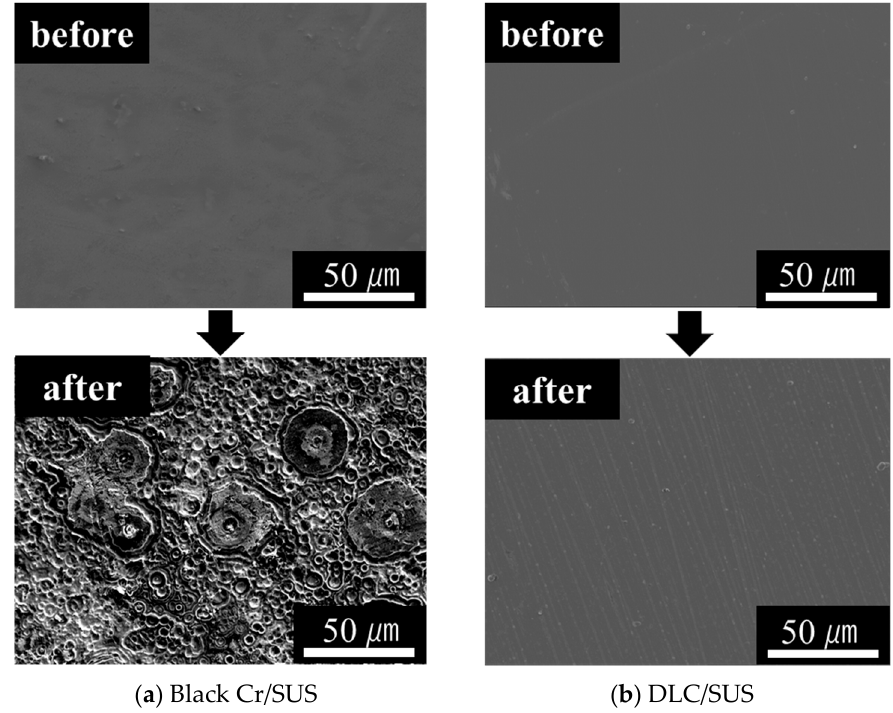
Figure 6. Scanning electron microscopy (SEM) images of ( a ) Black Cr/SUS; ( b ) DLC/SUS before and after immersion and sterilization tests.